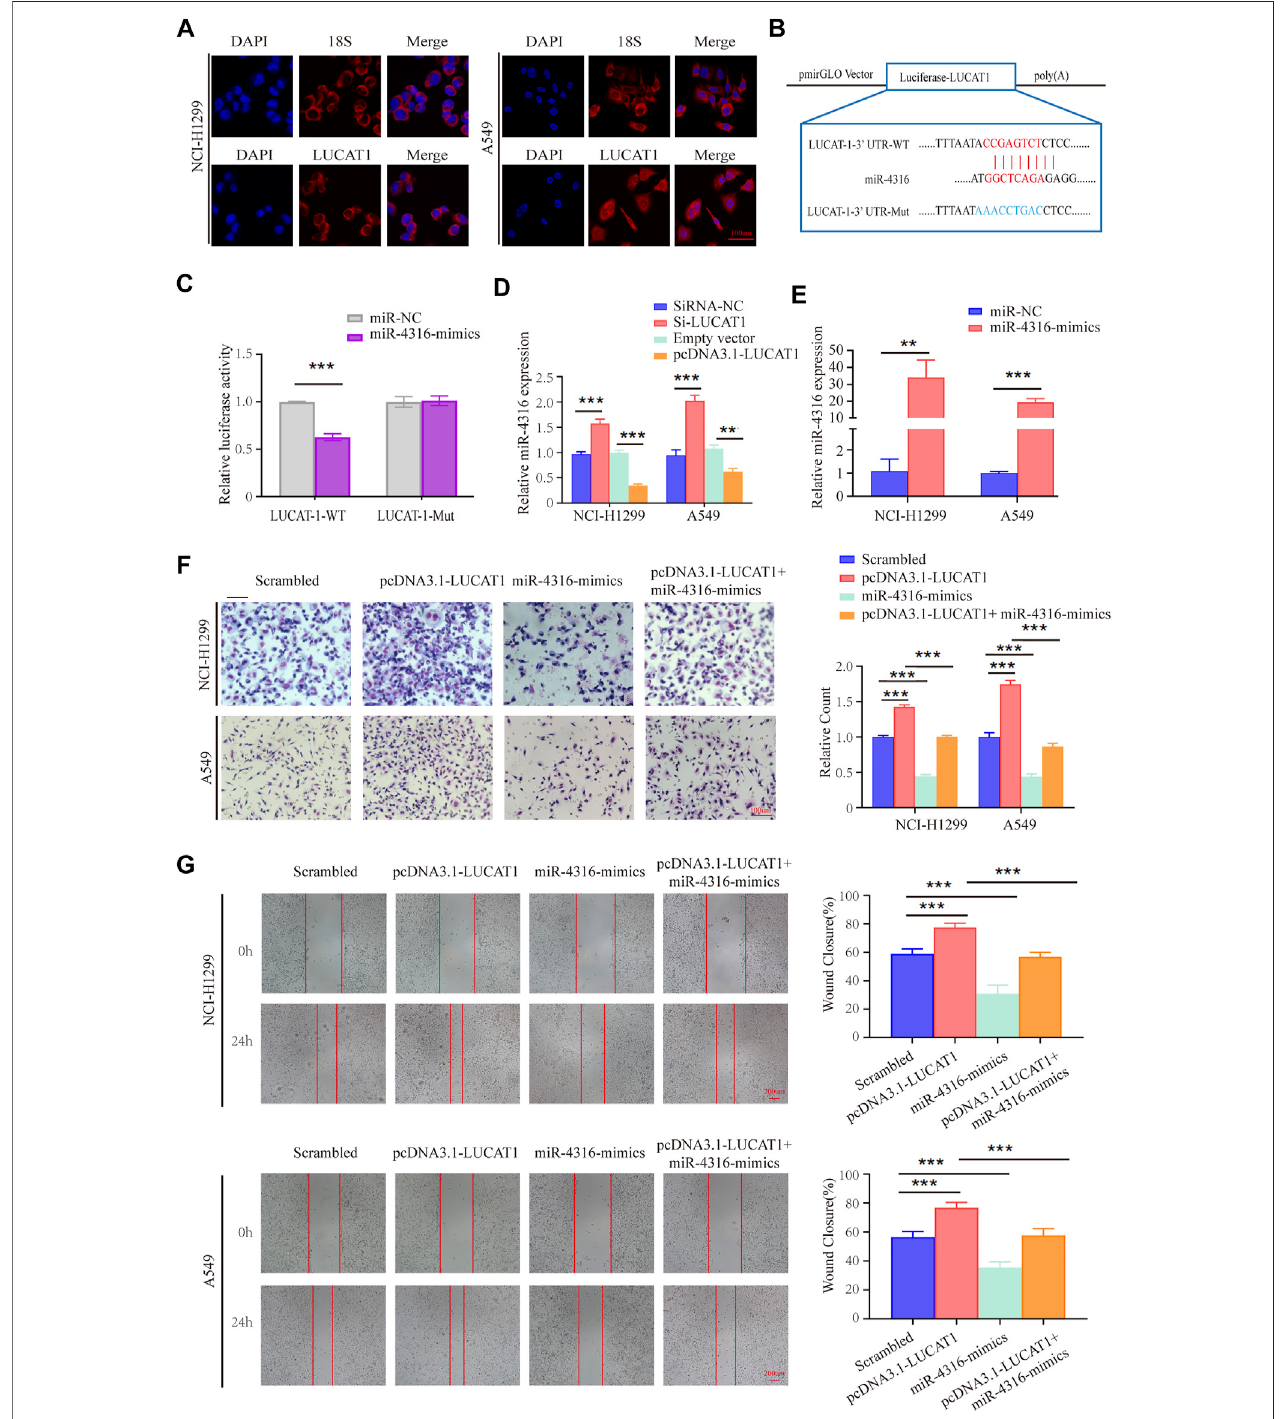
FIGURE 5 | LUCAT1 binds directly to miR-4316 and negatively regulates the expression of miR-4316. (A) Subcellular localization of LUCAT1 by RNA FISH. Red fl uorescent probe: LUCAT1 and 18s(Cy3 labelledprobes); blue fl uorescentprobe: DAPI. 18sserved asapositive control. Scale bar:100 µm. (B) Schematic diagram of thepotentialbindingsitesbetweenLUCAT1andmiR-4316. (C) Theluciferaseactivitywastestedafterco-transfectionwithwildtype(WT)/mutant3 ′ UTRofLUCAT1and miR-4316 mimics for 48 h. (D) Relative expression of miR-4316 in LUAD cells transfected with si-LUCAT, pcDNA3.1- LUCAT1 or control. (E) qRT-PCR was performed to detect the expression of miR-4316 in LUAD cells after transfection of miR-4316 mimics, or control. (F,G) Migration and invasion ability of LUAD cells co- transfected with negative control mimics, miR-4316 mimics, or/and overexpression plasmid (pcDNA3.1- LUCAT1) were determined by transwell and wound healing assays. p -values were calculated using two-tailed student ’ s t-test (* p < 0.05; ** p < 0.01; *** p < 0.001).